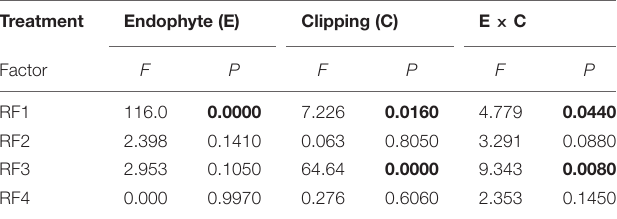
TABLE 2 | Two-way ANOVA for rotated factors of individual amino acids of Achnatherum sibiricum under endophyte infection and the clipping treatment.